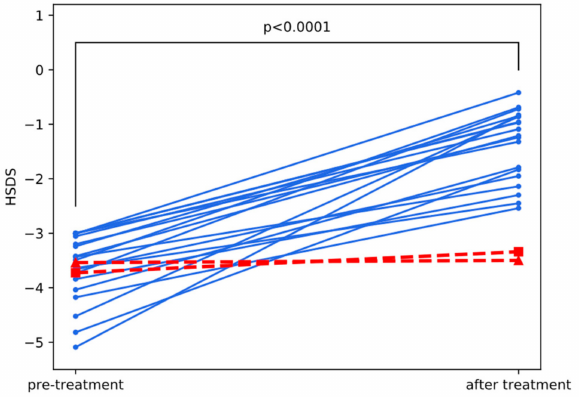
Figure 4. Comparison of pretreatment and final height in AGA-IGFD children. Red lines with triangle and square markers indicate nonresponders 1 and 2, respectively (Table 3). P -value from Wilcoxon